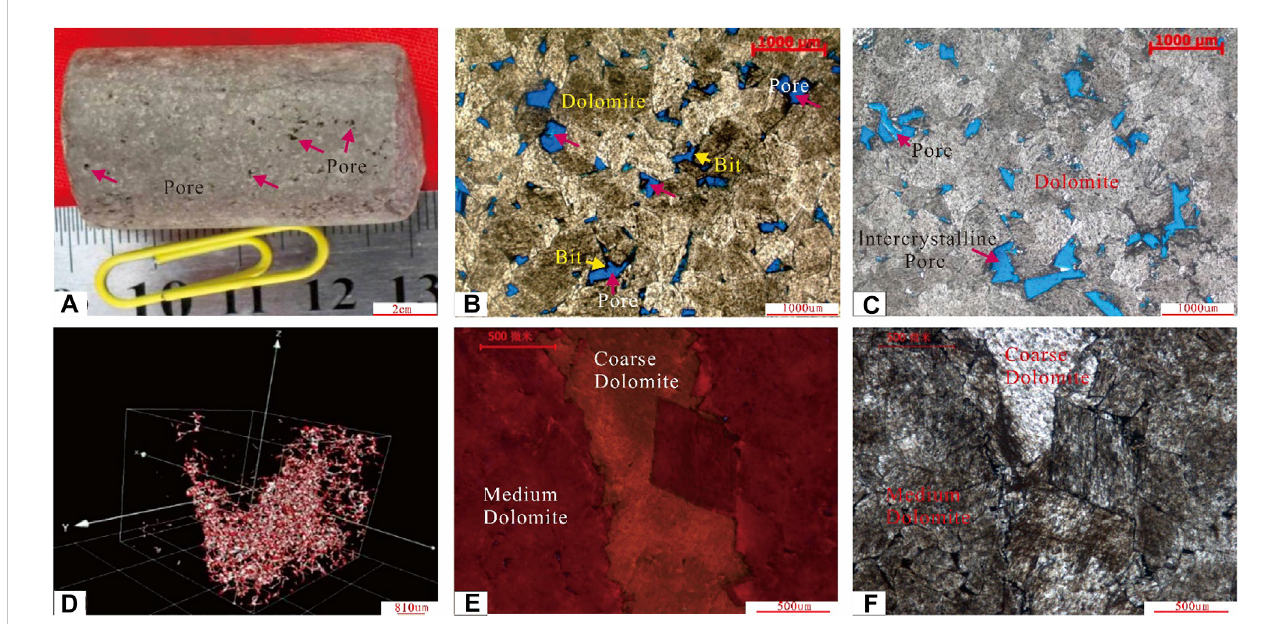
FIGURE 7 Reservoir space types and characteristics of the Ordovician karst-dolomitization reservoir in the Gucheng area, Tarim Basin. (A) Gray medium – coarse dolomite with dissolution pore-vugs (intergranular pore), Well GC13, the Yingshan Formation, 6,268 m; (B) medium – coarse dolomite with intercrystalline pores fi lled with bitumen, Well GC13, the Yingshan Formation, 6,268 m; (C) coarse dolomite with intercrystalline dissolution pores, Well GC9, the Yingshan Formation,6,095.50 m; (D) pore-throatnetwork model(withresolution of.9 um)withredrepresenting pores andwhiterepresenting throats,WellGC8, the Lower Yingshan Formation, 6,074.0 m; (E) medium – coarse dolomite with brown luminescence under the cathode ray and some crystals with red rims, WellGC14,theYingshanFormation,6,237.2 m; (F) medium – coarsedolomitewithcalcitehydrothermal fi lling,WellGC14,theYingshanFormation,6,237.2